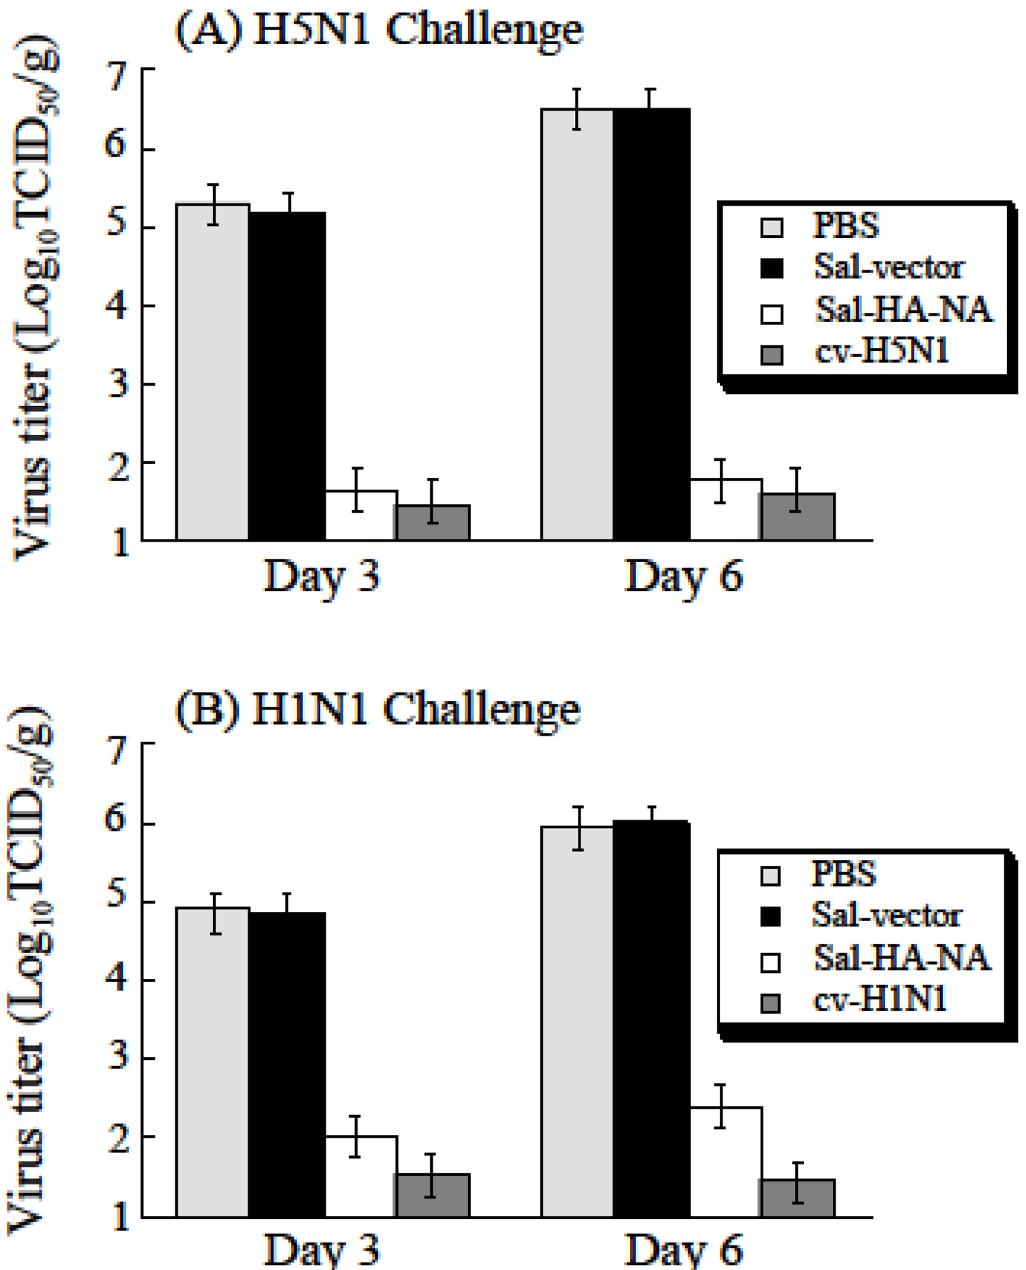
Fig 8. Virus titers in the lungs of mice challenged with H5N1 and H1N1 viruses. Mice were intragastrically immunized three times at day 0, 14, and 28 with PBS, the commercial H5N1 (cv-H5N1) and H1N1 vaccines (cv-H1N1), and Salmonella SL368 carrying the empty vector pVAX1 (Sal-vector) and constructs p5HA and p5NA (Sal-HA-NA), and then challenged intranasally with 20 LD 50 of lethal H5N1 (A/Viet Nam/1194R) and H1N1 (A/Puerto Rico/8/34) viruses at two weeks after final immunization. Lung tissues were harvested at 3 and 6 days post challenge and viral titers were determined. The experiments were performed in triplicate and were repeated three times, and the standard deviation is indicated by the error bar. The limit of detection was 1.0 log 10 TCID 50